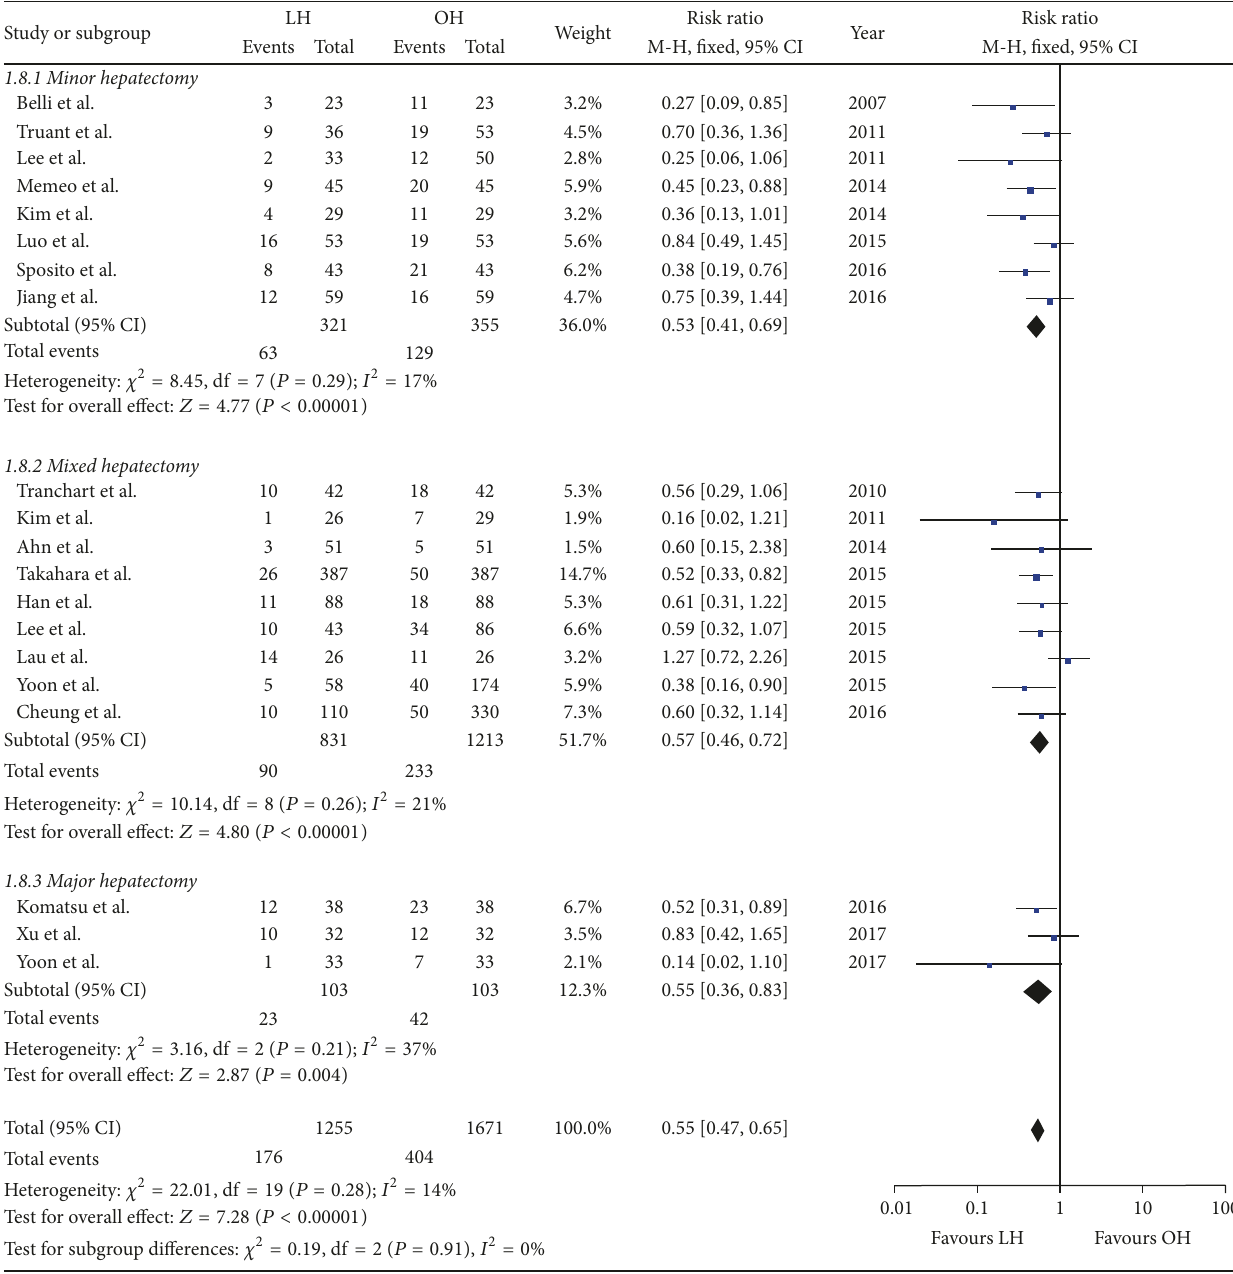
Figure 2: Forest plot of overall